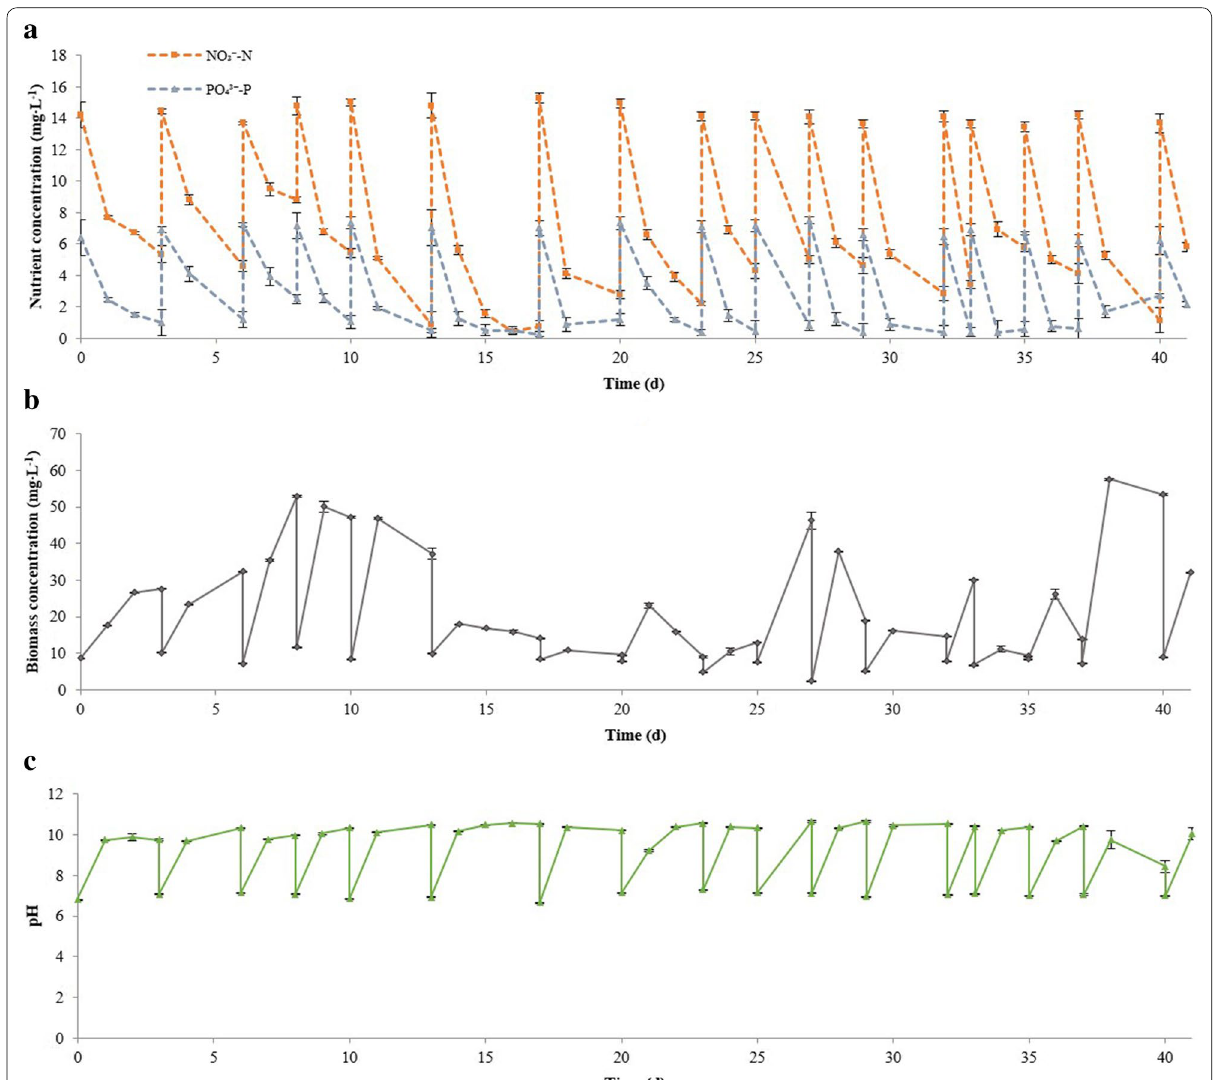
Fig. 7 C. vulgaris ACUF_809, a nitrogen (NO 3 − -N) and phosphorus (PO 4 3 − -P) removal kinetics in the PBR under semi-batch conditions; b pH changes in the medium of the biofilm photobioreactor and c microalgal biomass growth in the medium of the biofilm